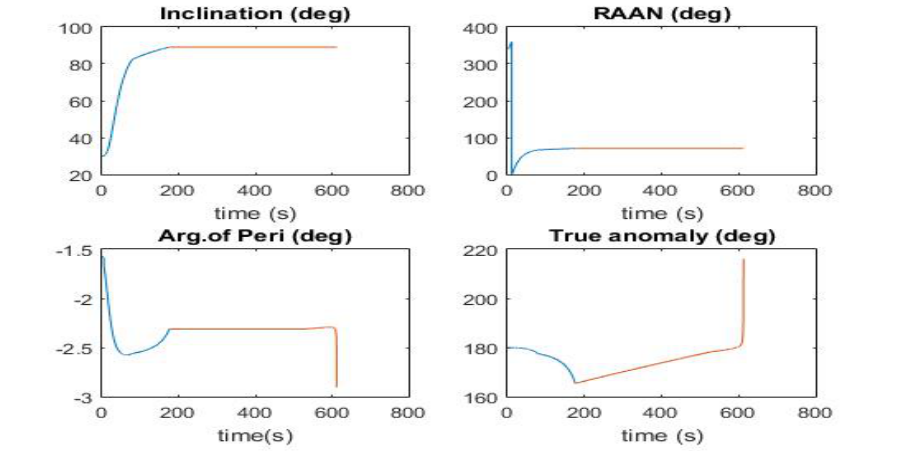
Figure 9. Thein-plane orbit parameters during the ascent. First-stage parameters are the blue line; coasting and second stage are the orange line.